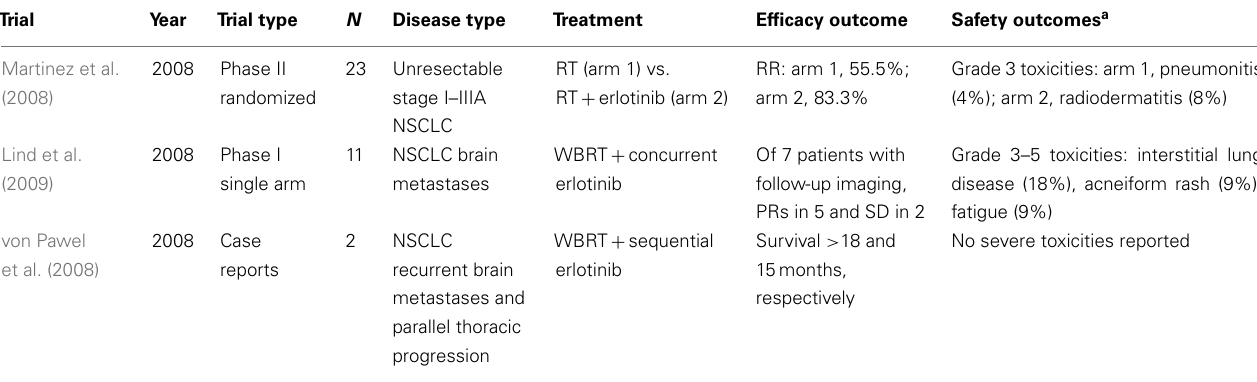
Table 2 | Recent trials of erlotinib and radiotherapy in